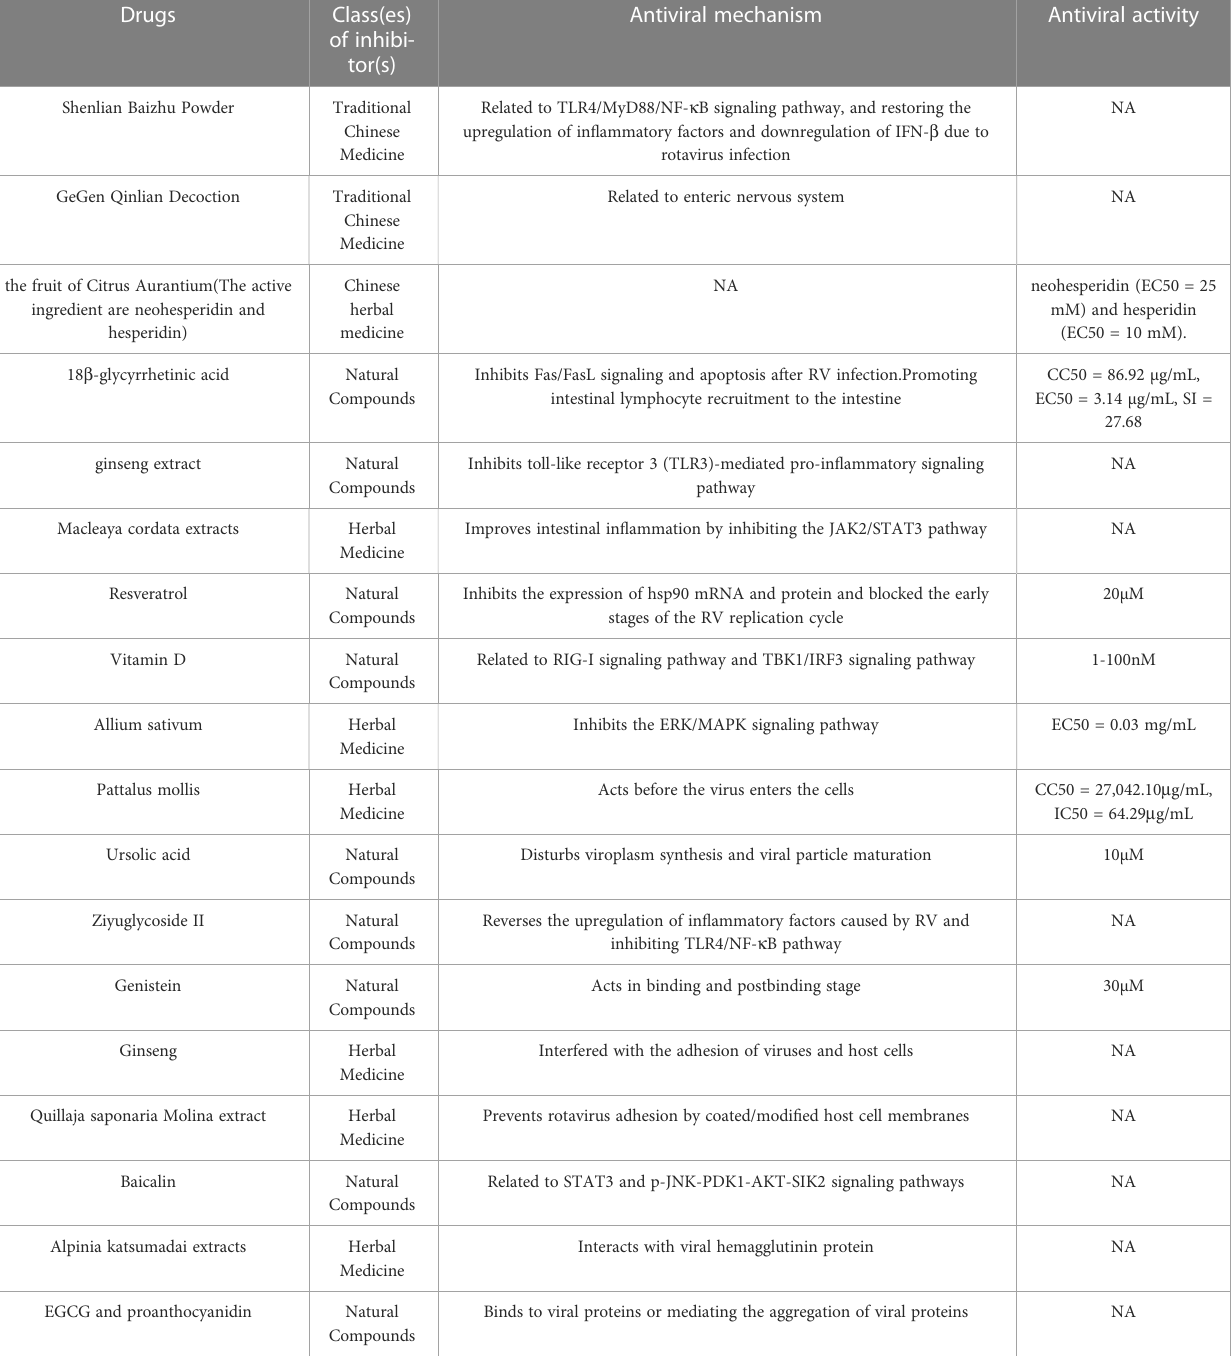
TABLE 3 Chinese medicine and natural